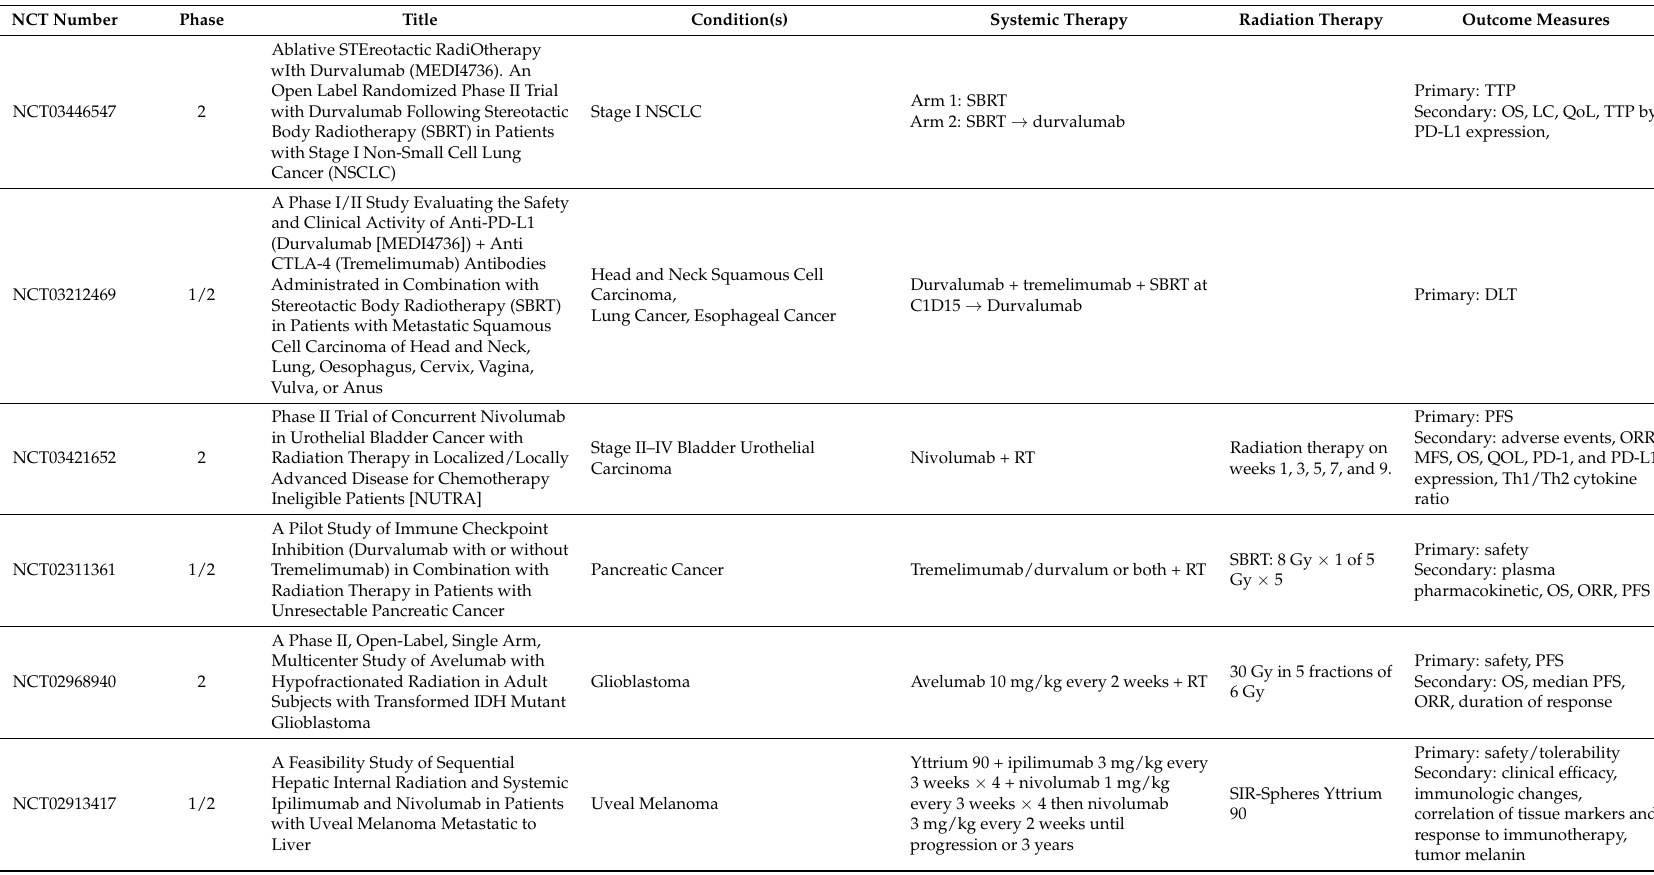
Systemic Therapy Radiation Therapy Outcome Measures